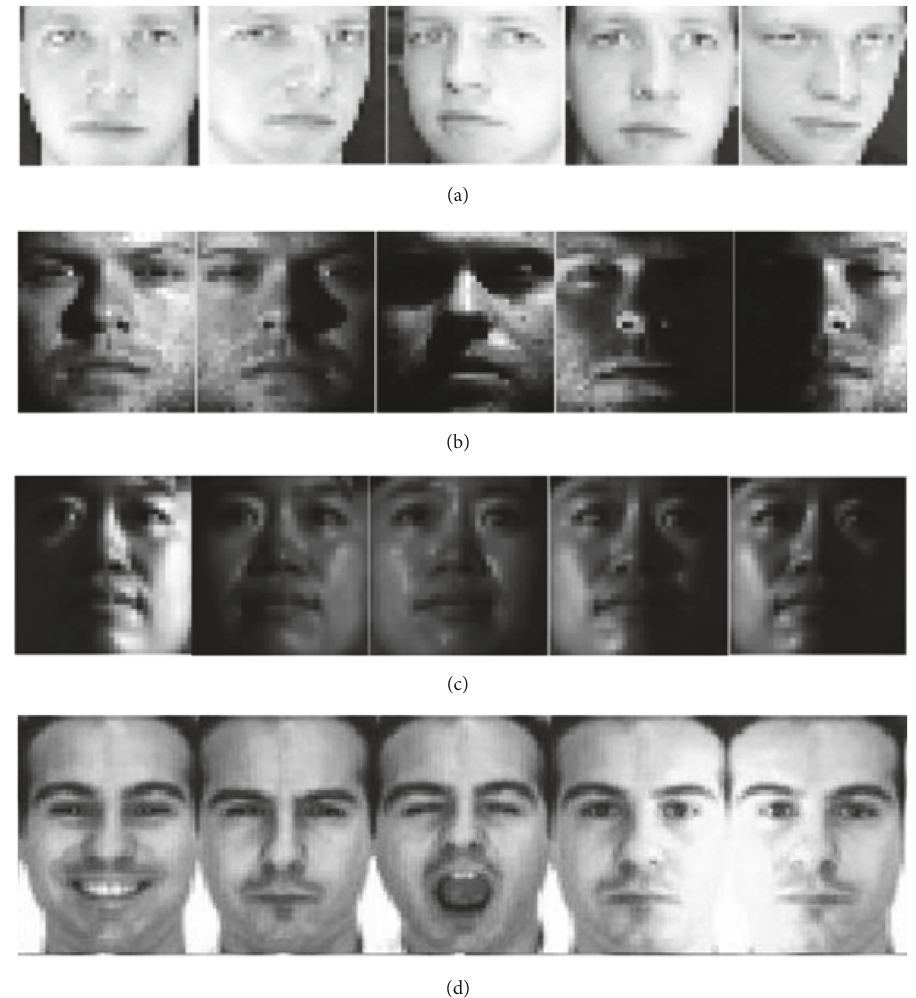
Figure 5: Some facial images used in our experiments: (a) the ORL dataset; (b) the Extended Yale B dataset; (c) the CMU PIE dataset; (d) the AR dataset.